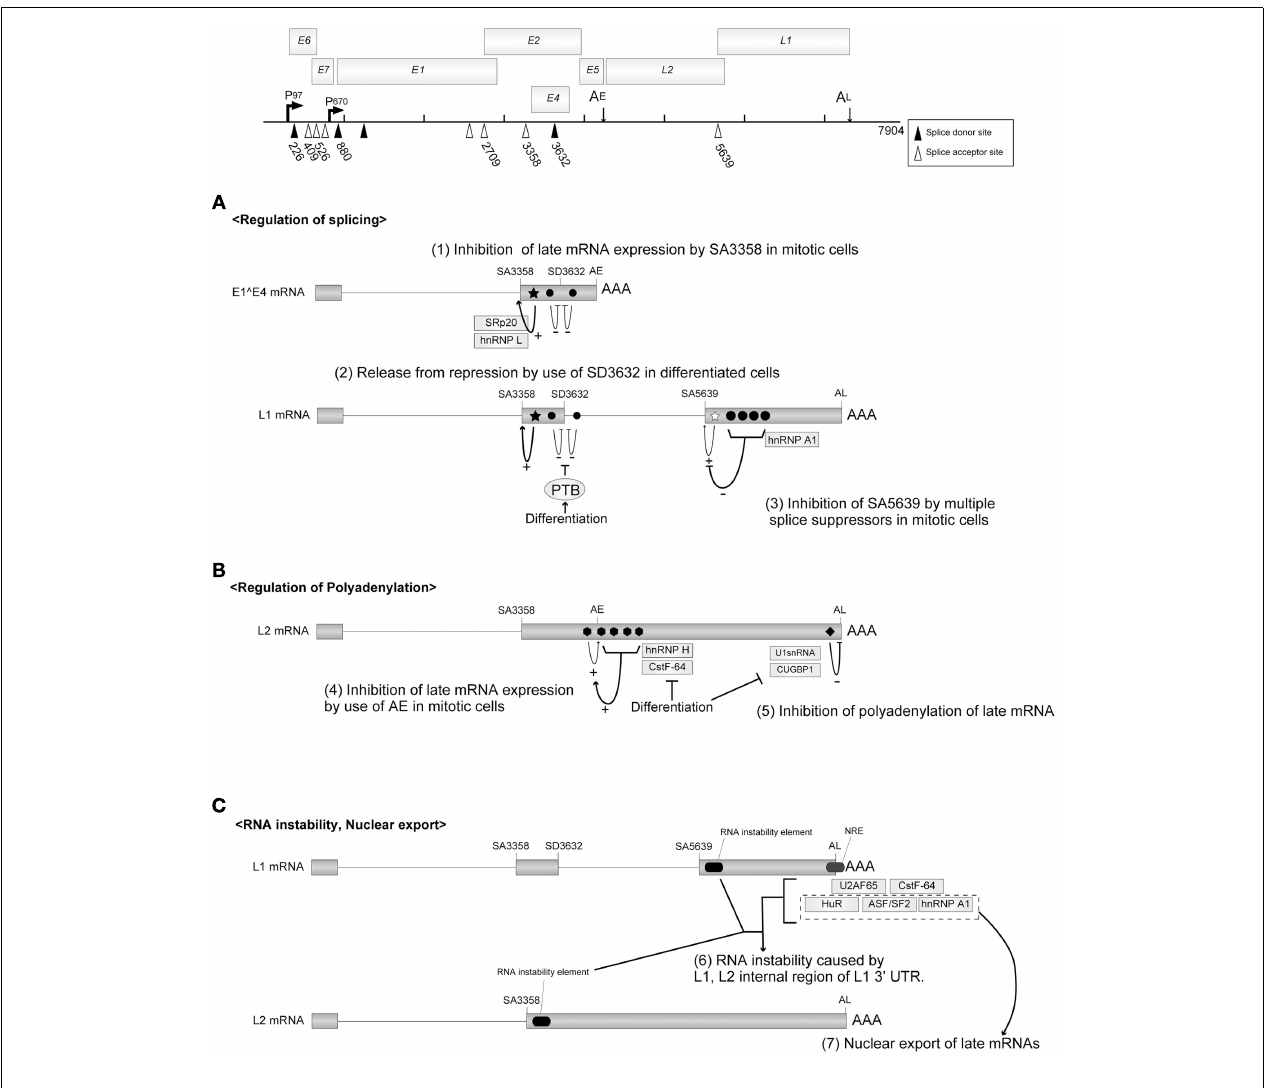
(splicing silencers). (B) HPV16 polyadenylation regulatory elements are indicated as filled hexagons (polyadenylation stimulatory elements) and a filled rectangle (polyadenylation inhibitory element). (C) The regulatory elements for the instability and nuclear export of HPV16 late mRNA are indicated.This figure is cited from a review (Schwartz,